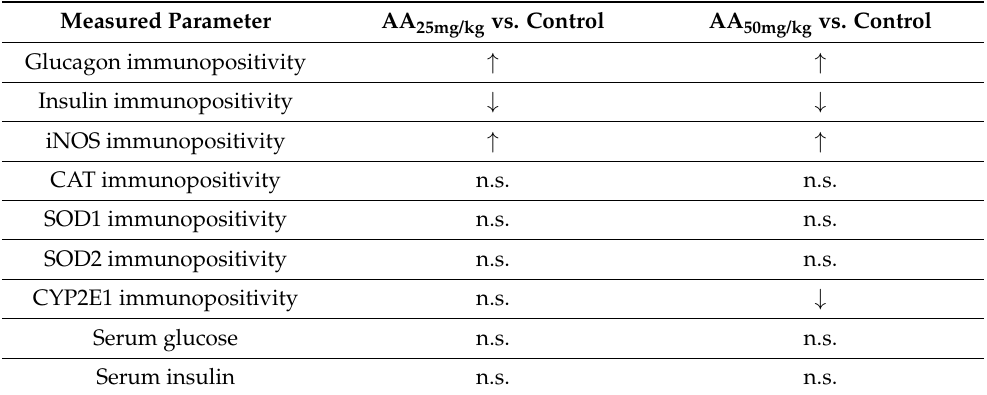
Figure 3. Hematoxylin and eosin (HE)-stained pancreatic islets of control and AA-treated rats. Male Wistar rats were treated with AA in doses of 25 mg/kg b.w./d and 50 mg/kg b.w./d; 400× light microscope magnification [58]. Table 1. Effect of AA application on relevant glucose metabolism and toxicity parameters of pancreatic islets in male rats. Adult male Wistar rats were treated with 25 mg/kg b.w./d, and 50 mg/kg b.w./d of AA for three weeks [58,62].